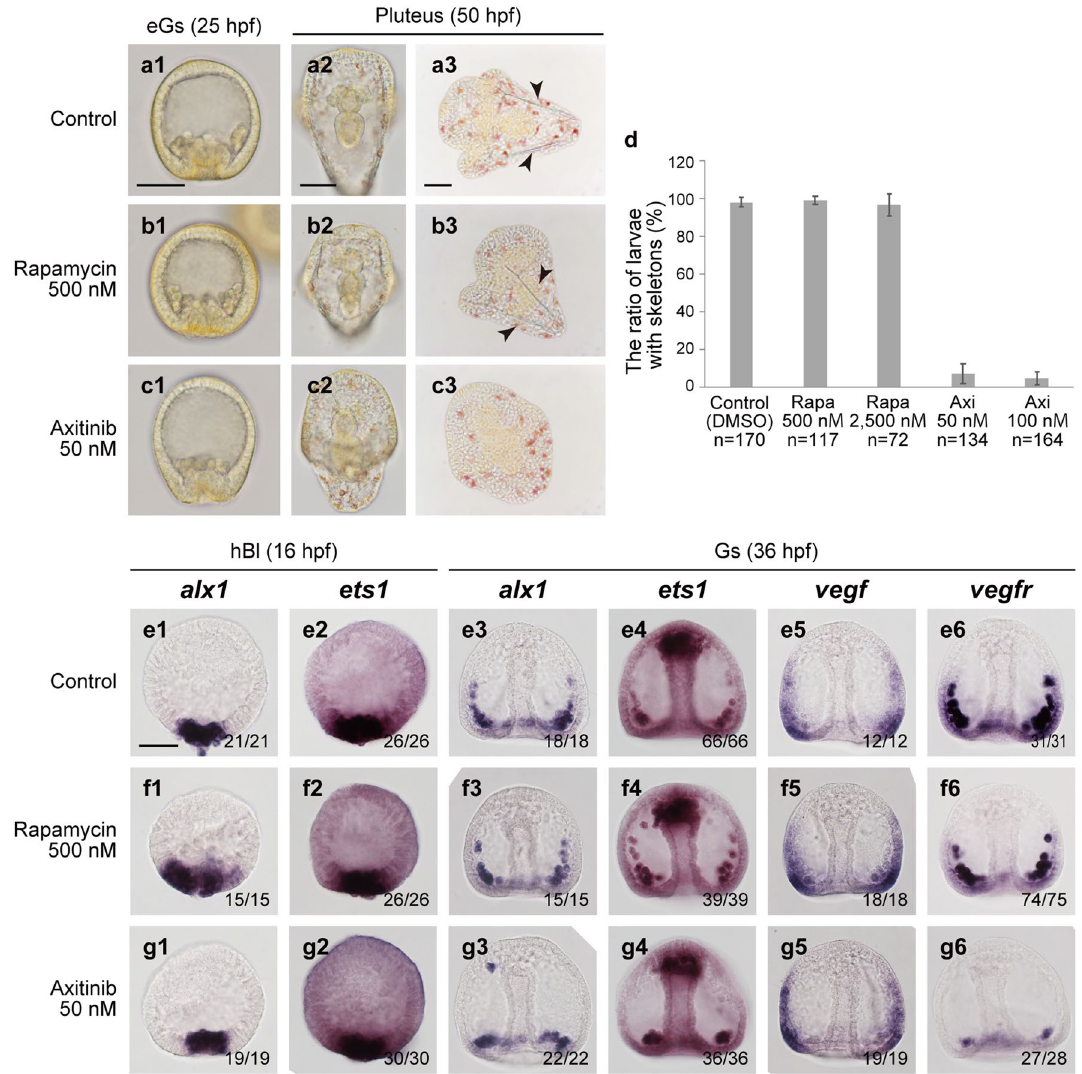
Figure 7. Treatment with rapamycin or axitinib in embryos of the sea urchin Hemicentrotus pulcherrimus . Morphology, the formation of larval skeletons, and gene expression were observed in the control ( a1 – a3 , e1 – e6 ), rapamycin (rapa)-treated ( b1 – b3 , f1 – f6 ) and axitinib (axi)-treated larvae ( c1 – c3 , g1 – g6 ). ( a – c ) Living embryo or larva at the early gastrula (eGs; 25 hpf) and pluteus (50 hpf) stages. For the observation of larval skeletons, the larvae were pressed ( a3 – c3 ). In panels of a3 and b3, arrowheads indicate larval skeletons. ( d ) The ratio of larvae with skeletons was evaluated. The total numbers of larvae examined are shown at the bottom. The expression of alx1 , ets1 , vegf and vegfr was examined in the control embryos treated with DMSO ( e1 – e6 ), rapamycin-treated embryos ( f1 – f6 ) and axitinib-treated embryos ( g1 – g6 ) at the hatched blastula (hBl; 16 hpf) and gastrula (Gs; 36 hpf) stages. The numbers in the lower right corner show the number of embryos showing a positive WMISH signal/the total number of embryos examined. All WMISH images except for that in panel f1 show typical expression patterns, whereas panel f1 shows an atypical expanded expression pattern (5 of 15 embryos). Scale bars: 50 μm. M: